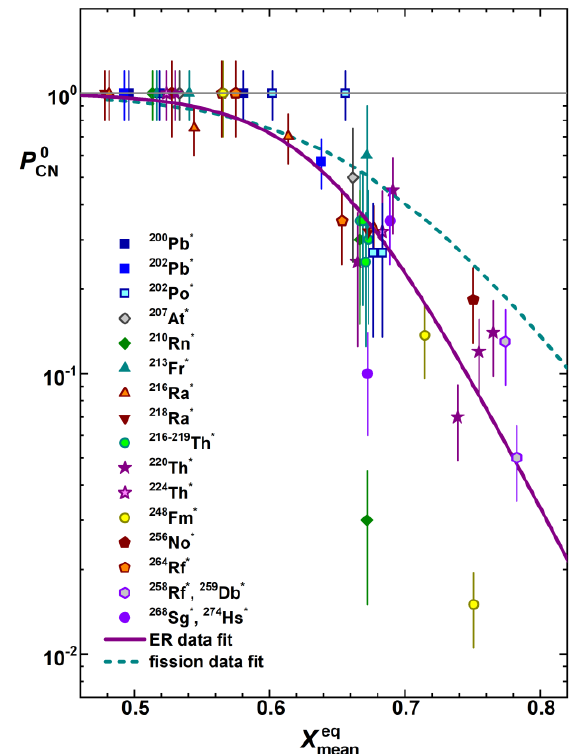
Fig. 6. The P CN data derived from the analysis of ER cross sections obtained in complete fusion reactions with the different mass-asymmetry in the entrance channel and leading to the same CN (designated by the corresponding symbol) are fitted with a function of the equilibrated mean fissility (a solid line). The result of the same function fit to the P CN data obtained in fission studies (see Figs. 1 and 2) is shown by a dashed line. See the text for more